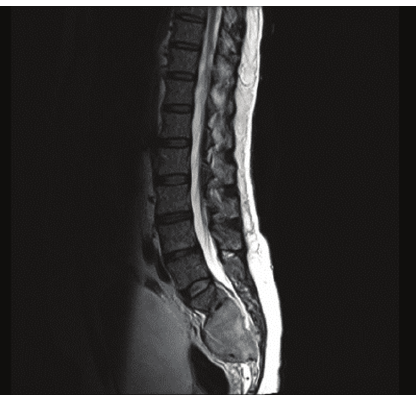
Figure3:MRIrevealinglargesofttissuemassinsacralregioncausingseverecanalstenosisandcompressionofthesacralnerverootsresulting in cauda equina